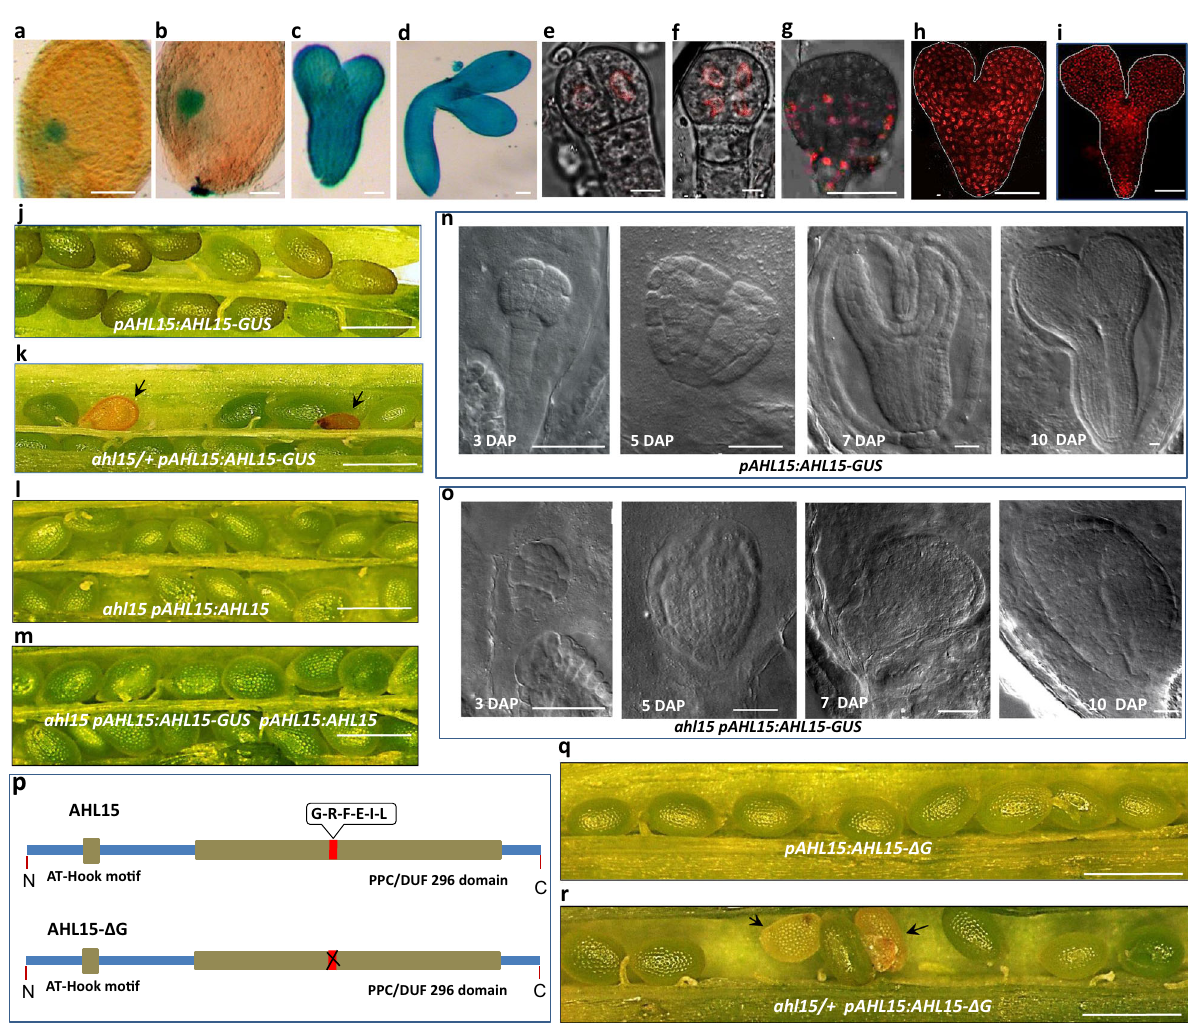
Fig. 2 AHL15 is expressed and essential during ZE. a – d Expression pattern of pAHL15:AHL15-GUS in globular-stage ( a ), heart-stage ( b ), torpedo-stage ( c ) and bent cotyledon ( d ) stage embryos. e – i Confocal microscopy images of pAHL15:AHL15-tagRFP four cell ( e ), 8 cell-stage ( f ), globular-stage ( g ), heart- stage ( h ), and torpedo-stage ( i ) embryos. j Wild-type seed development in a pAHL15:AHL15-GUS silique. k Aberrant seed development (arrowheads) in a ahl15/ + pAHL15:AHL15-GUS silique. l , m Wild-type seed development in ahl15 pAHL15:AHL15 ( l ) or ahl15 pAHL15:AHL15 pAHL15:AHL15-GUS ( m ) siliques. n , o DIC images of zygotic embryo development in siliques of pAHL15:AHL15-GUS ( n ) or ahl15/ + pAHL15:AHL15-GUS ( o ) plants at 3, 5, 7, or 10 days after pollination (DAP). p Schematic domain structure of AHL15 and the dominant negative AHL15- Δ G version, in which six-conserved amino-acids (Gly-Arg- Phe-Glu-Ile-Leu, red box) are deleted from the C-terminal PPC domain. q Wild-type seed development in pAHL15:AHL15- Δ G siliques. r Aberrant seed development (arrowheads) in ahl15/ + pAHL15:AHL15- Δ G siliques (observed in three independent pAHL15:AHL15- Δ G lines crossed with the ahl15 mutant). a – r Similar results were obtained from two independent experiments. Size bar indicates 100 µ m ( a – d , g – l ), 10 µ m ( e , f ), 1 mm ( j – m, q , r ) and 40 µ m ( n , o